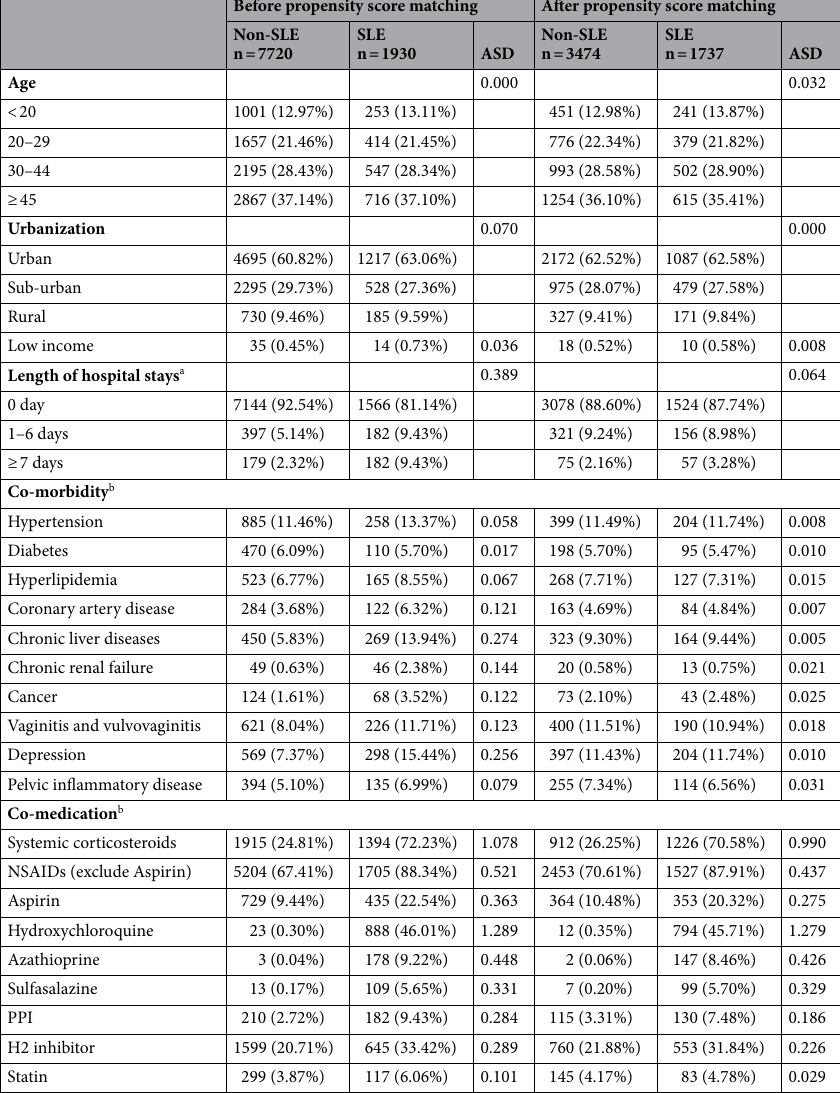
Table 1. Baseline characteristics among study groups. a The length of hospital stays, comorbidities were identified within 1 year before the index date. b The co-medication was identified between one year before and three months after the index date.